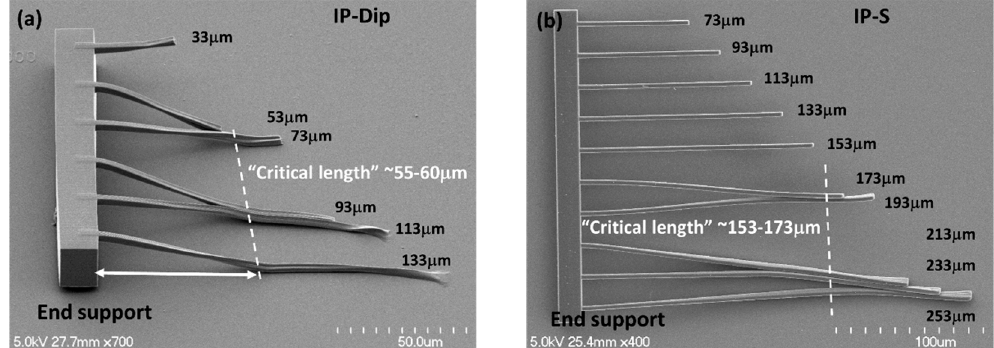
Figure 6 . Cantilever beam structures of varying lengths with an integrated end support printed in ( a ) IP-Dip and ( b ) IP-S resin. The printed beam width is 3 μ m with a lateral spacing between beams of ~20 μ m and vertically suspended above the base substrate by ~20 μ m. The “critical length” for collapse under capillary drying forces is indicated by the dashed line.